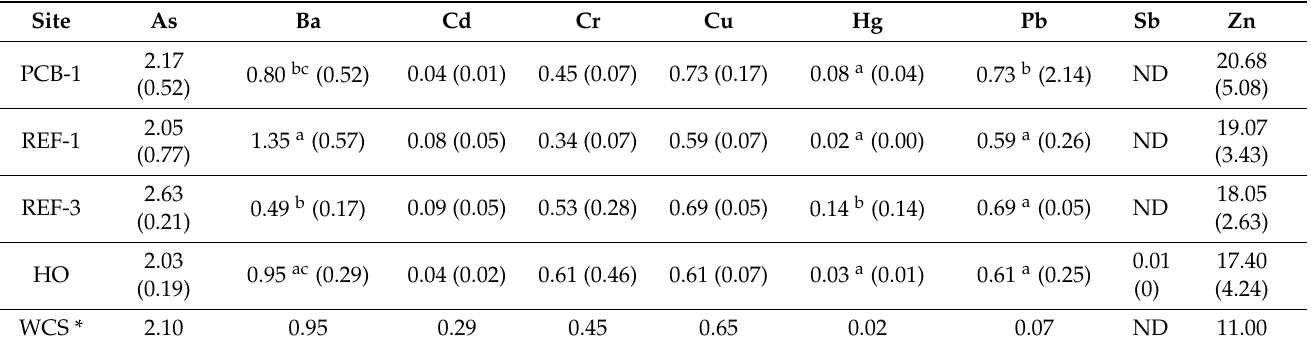
Table 9. Mean (SD) metal concentrations (mg/g) in damselfish tissues from Johnston Atoll. Sites with different letters are significantly different at p <